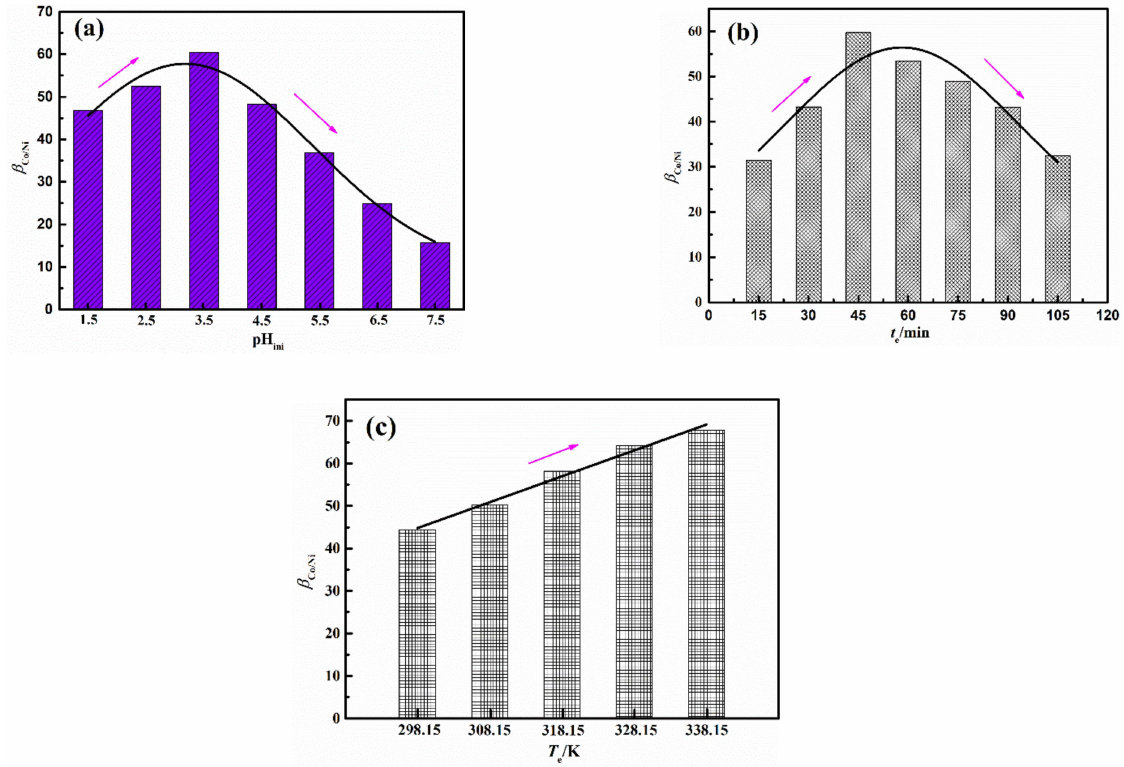
Figure 3. Effect of pH ini on β Co/Ni ( a ); effect of t e on β Co/Ni ( b ); effect of T e on β Co/Ni ( c